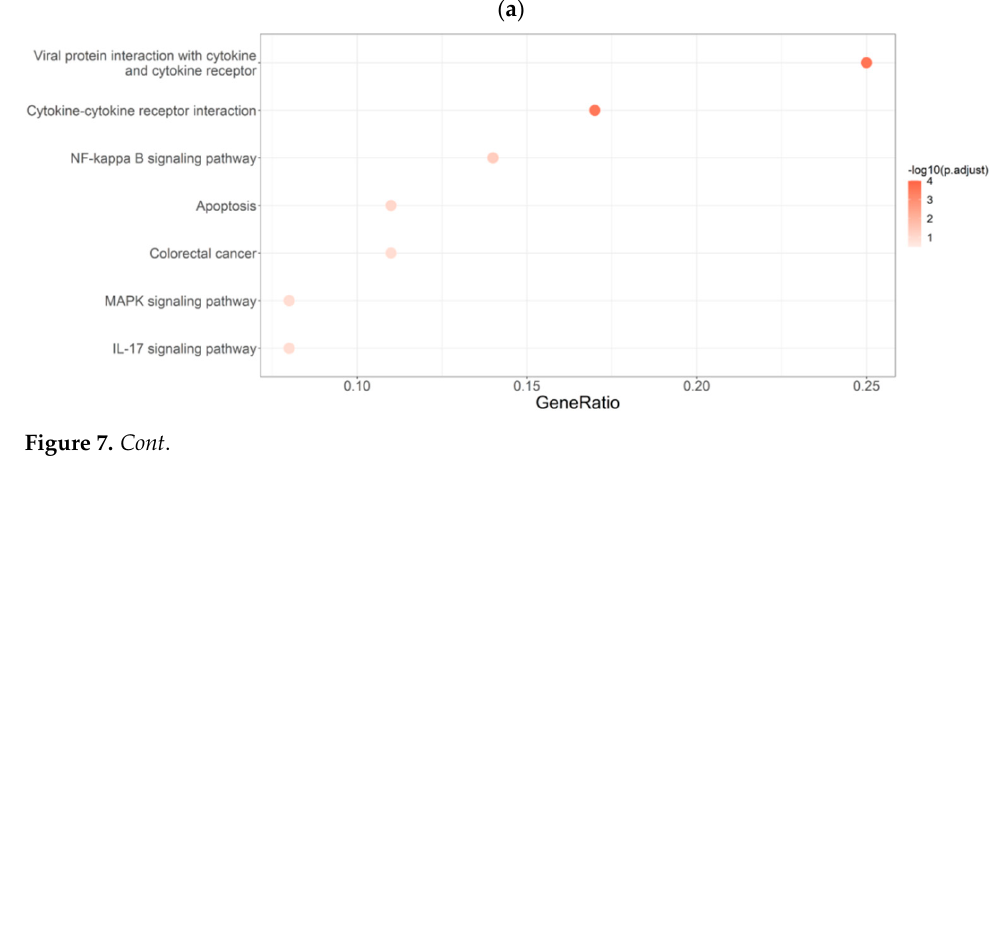
( c ) Figure 7. Gene functional analyses. ( a , b ) Bubble diagram and treemap illustrating the top 7 KEGG pathways and GO terms enriched by DEGs with the same regulation direction in two sites. ( c ) Heatmap showing the result of GSVA using biological process − related GO terms.